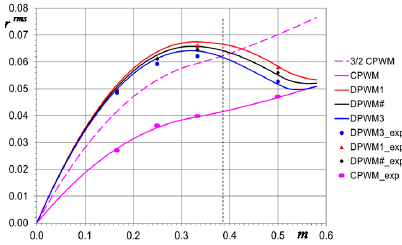
Figure 21. Approximated normalized current ripple rms (lines) compared to the experimental results (dots) for DPWM and CPWM techniques